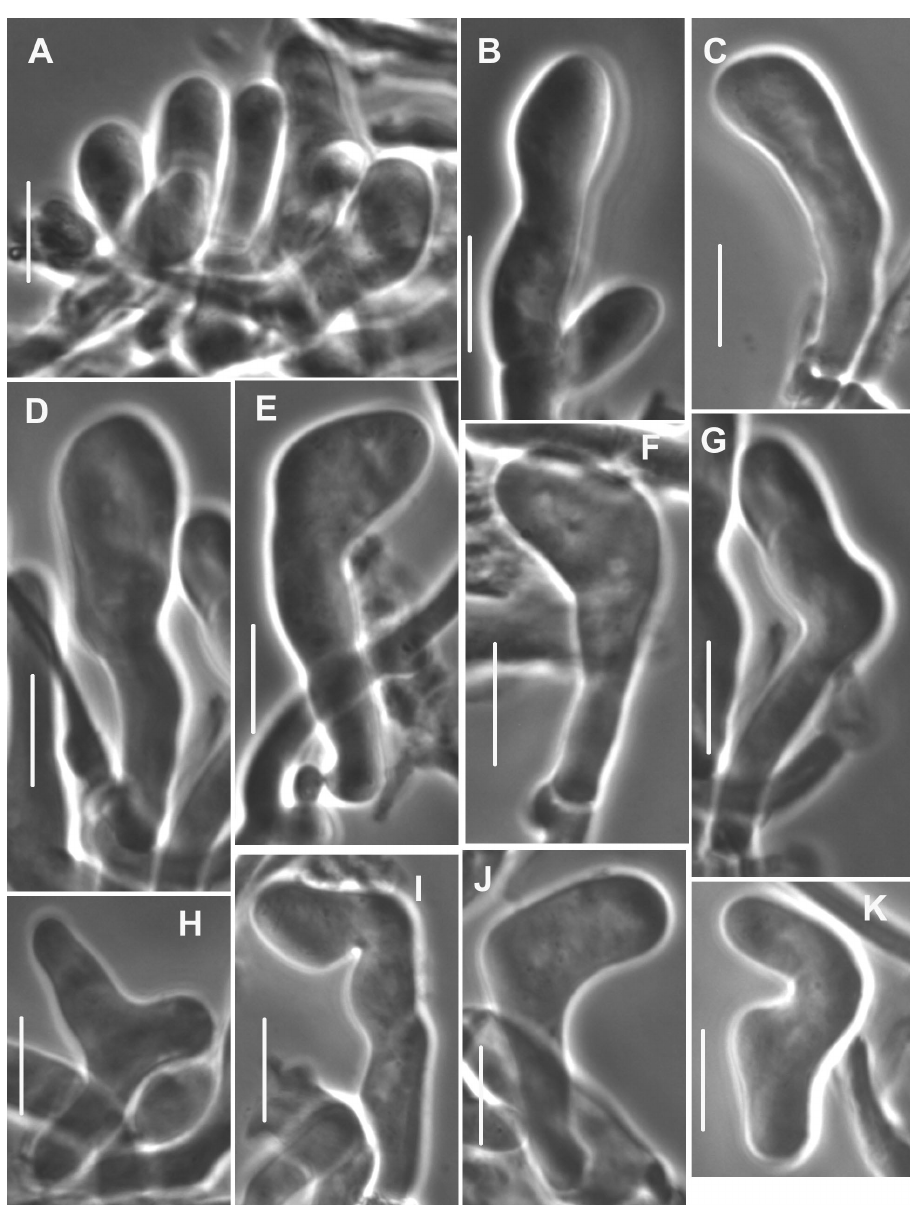
Figure 39. Mycetinis kallioneus . Caulocystidia from stipe apex. A Cluster of caulocystidia B–K Indi- vidual caulocystidia. Standard bars = 10 µm. TB 85-209